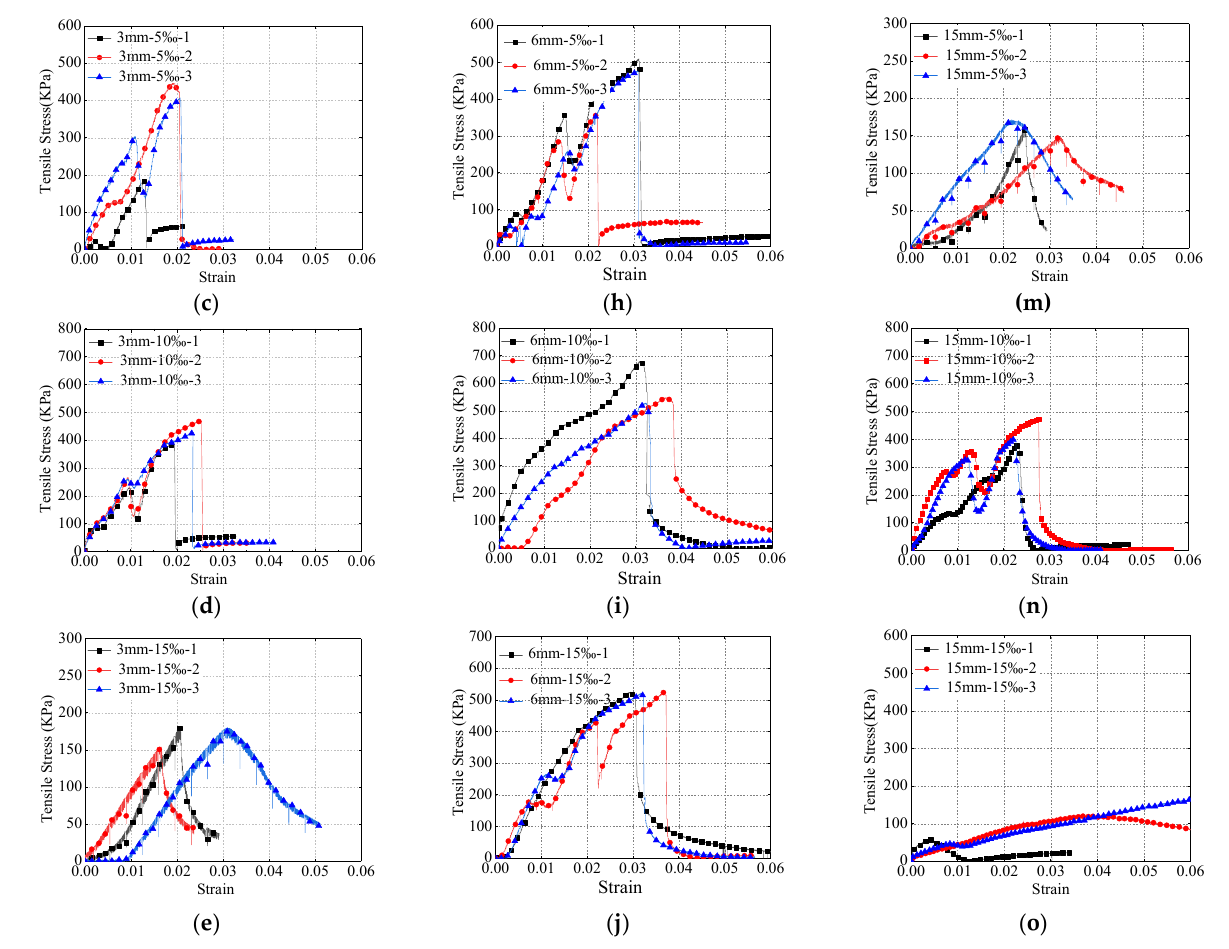
Figure 9. Tensile stress–strain curves for different mix ratios ( a – o ). Table 4. Experimental tensile strength values of tested